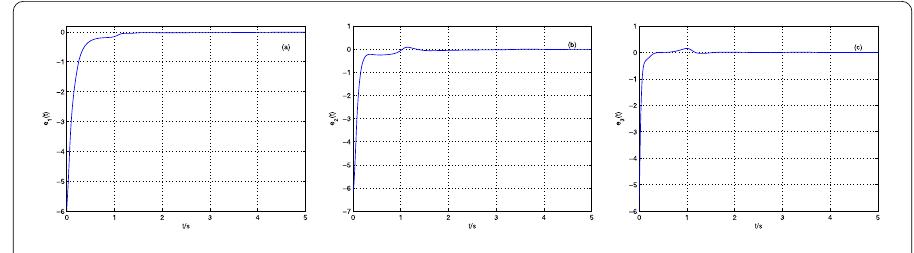
Figure 4 Time waveforms of synchronization errors e 1 (a), e 2 (b) and e 3 (c) between two fractional-order Liu